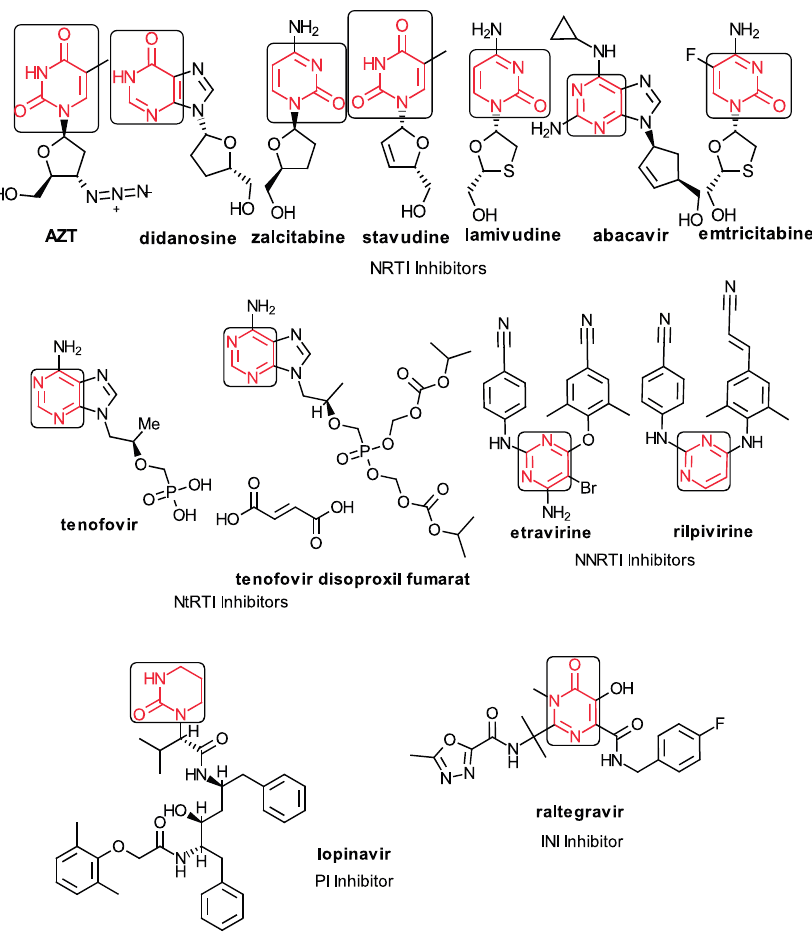
Figure 1. Pyrimidine derivatives used in the treatment of HIV/AIDS; the emphasized molecular fragments—also represented in the color red—are studied in this